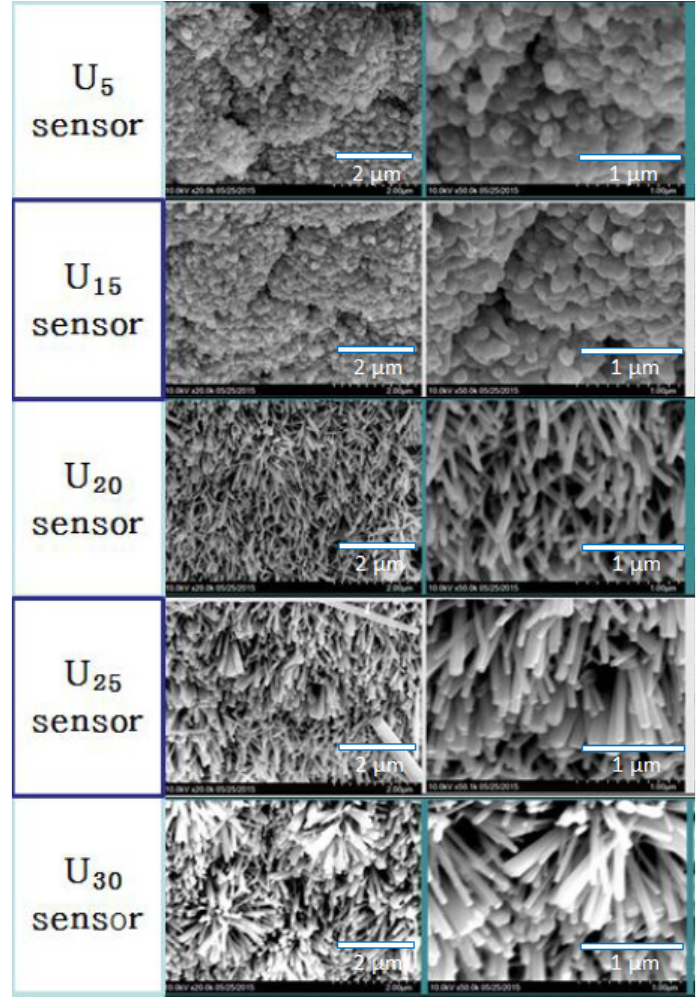
Figure 3. FESEM images of the ZnO nanostructures.